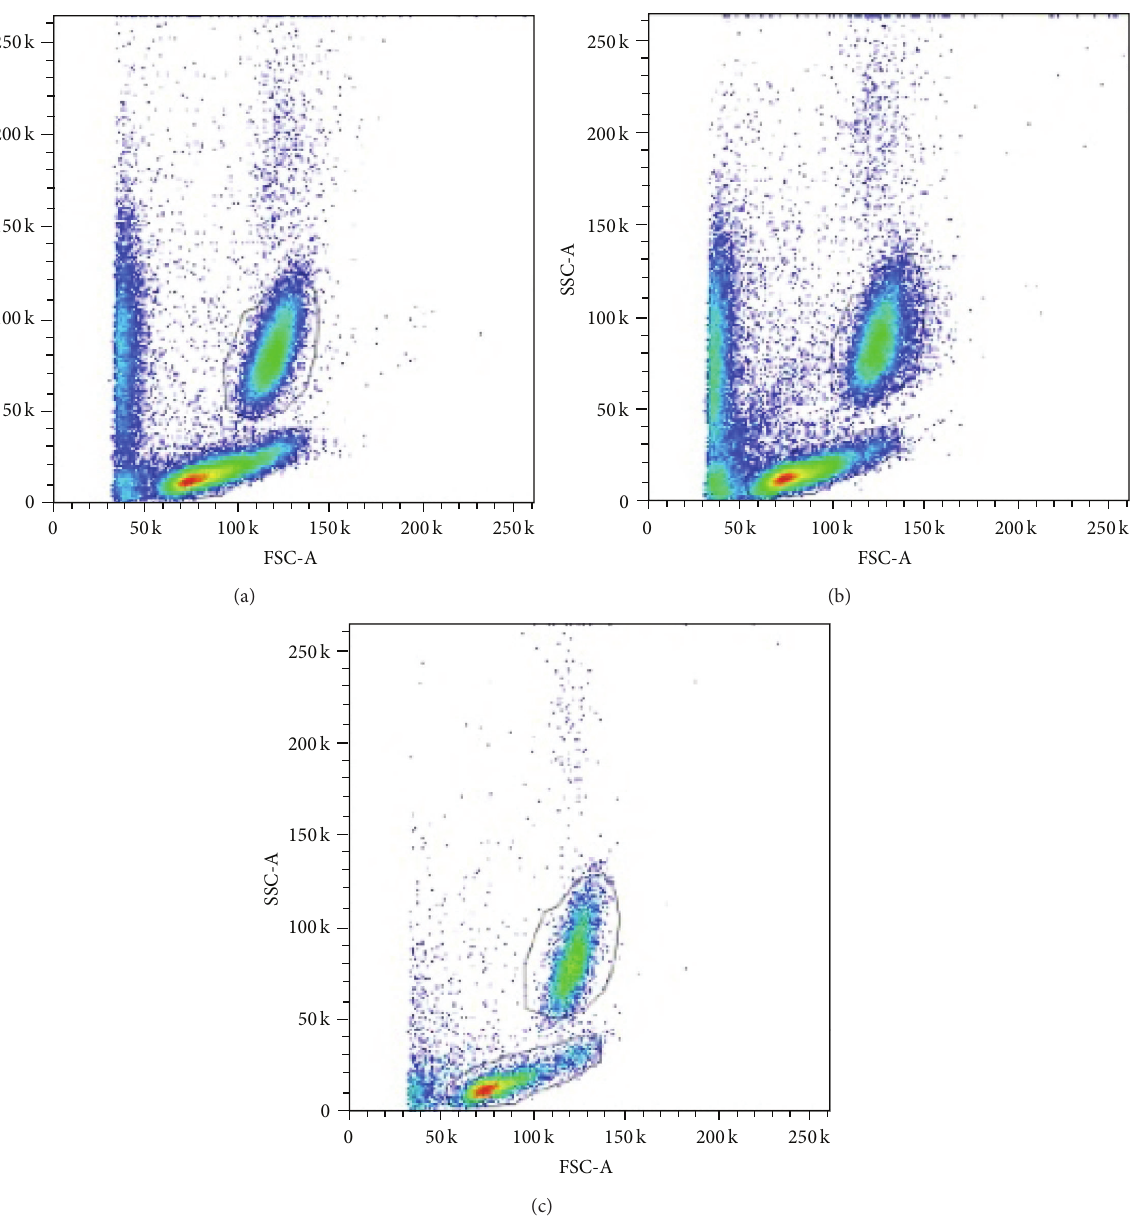
Figure 2: Representative flow-cytometry analysis at baseline (a), after ECC without oxygenator (b) and after ECC with oxygenator (c). A significant depletion of mononuclear cells and granulocytes after ECC + oxygenator is